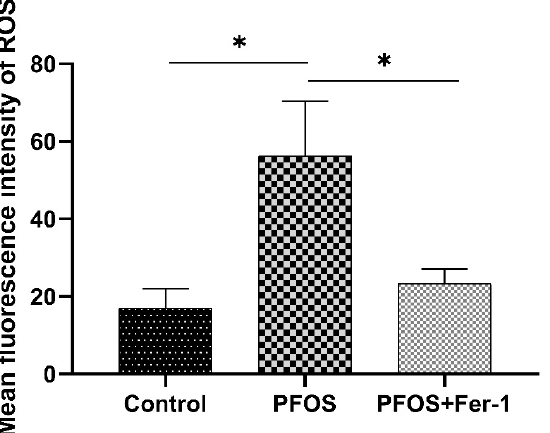
Figure 5. ROS production determined by immunofluorescence in HK ‐ 2 cells exposed to PFOS or/and Fer ‐ 1. HK ‐ 2 cells were exposed to PFOS at 200 μ M for 12 h or/and cultured with Fer ‐ 1 at 1 μ M for 2 h prior to exposure to PFOS; the results were from three independent experiments.